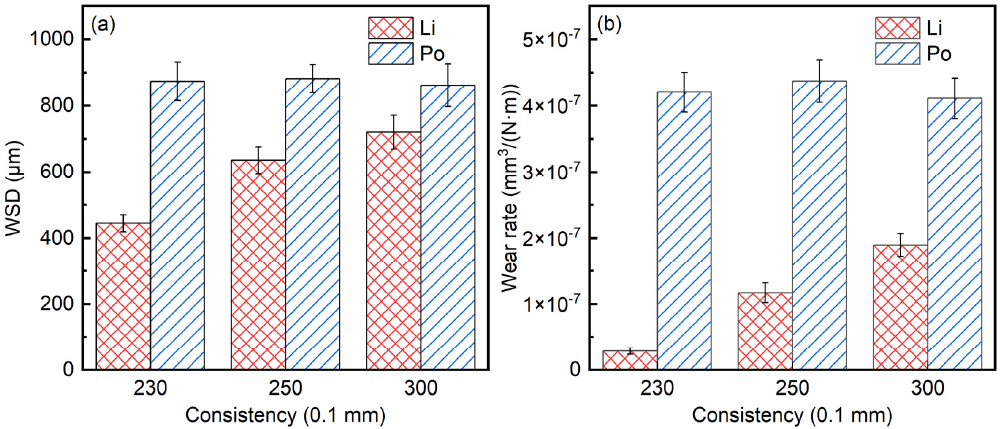
Figure 14. Wear rates and WSD of greases with different consistencies: ( a ) WSD, ( b ) wear rates.